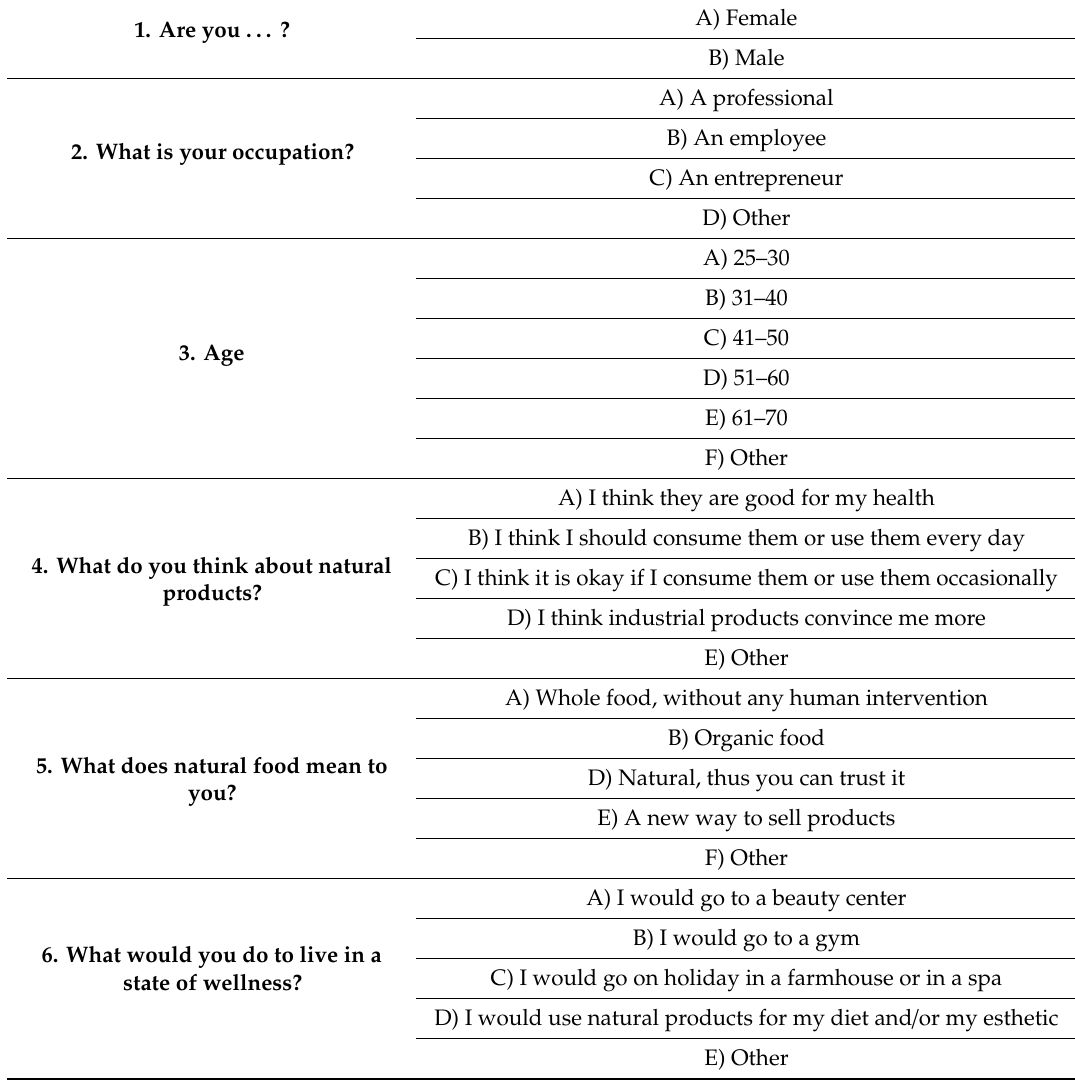
Figure 3. SANI labels and marketing approach. Following the directions of the SANI marketing approach (1–4), the shopping cart is enriched with many healthy products, each with a different label to help achieve a balanced, healthy, complete, and sustainable diet. Table 2. SANI